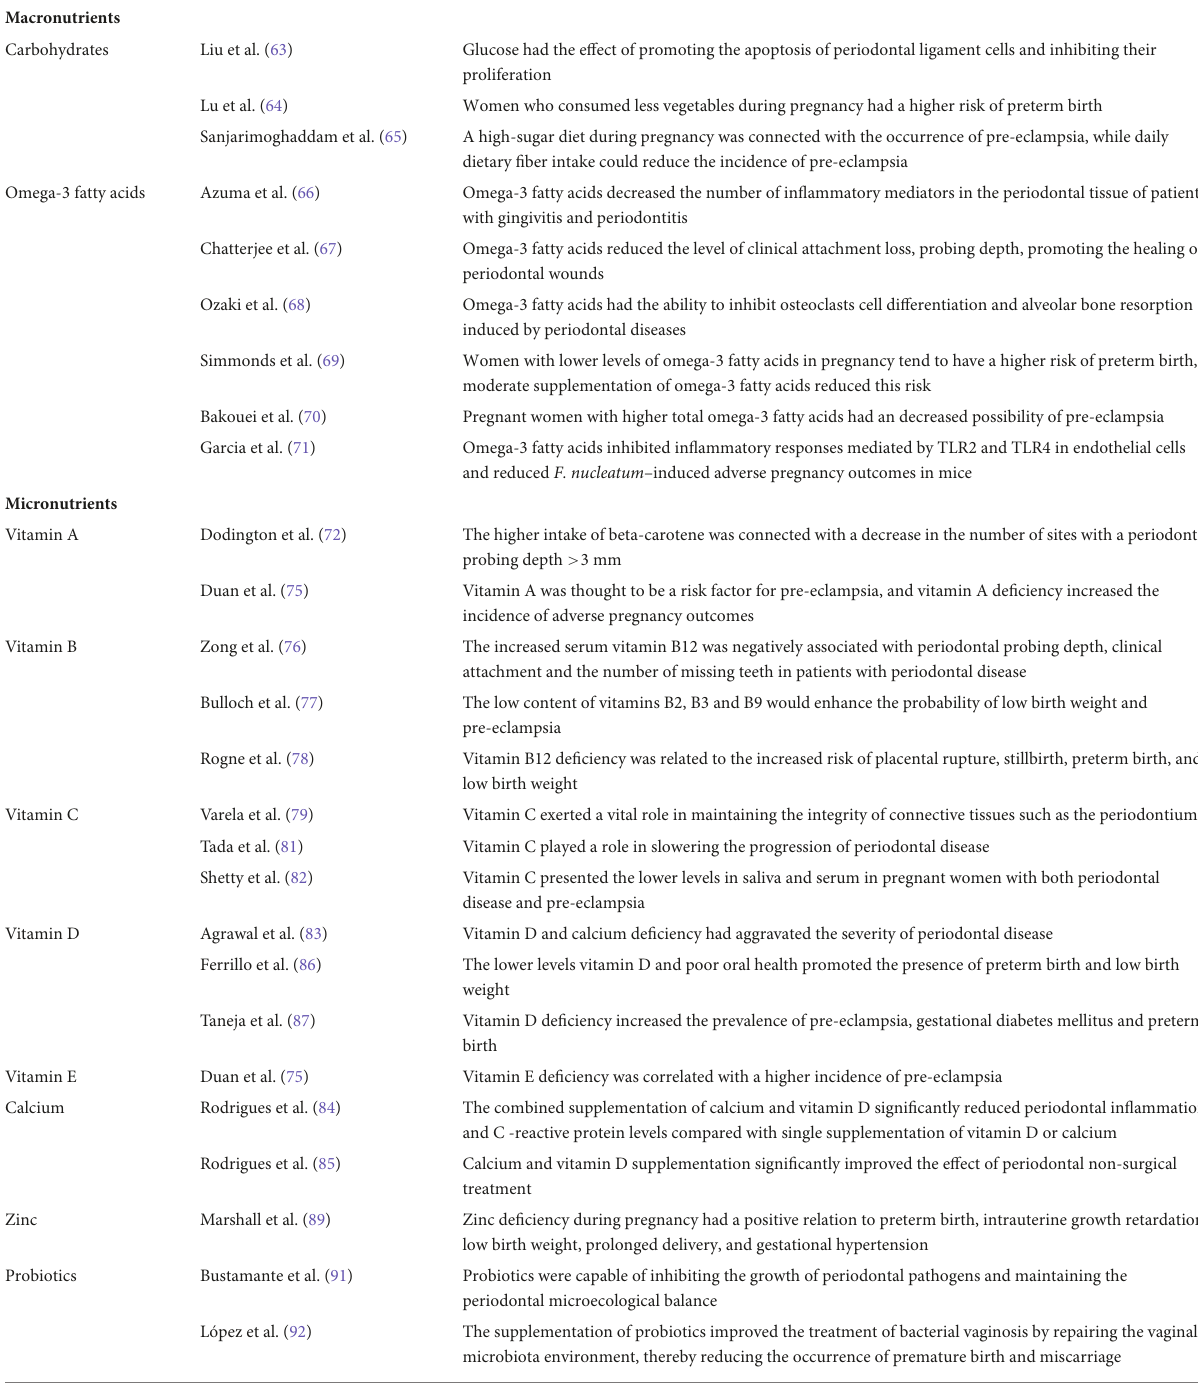
TABLE 1 The studies of the effect of nutritional intake on periodontal disease and adverse pregnancy outcomes during pregnancy.